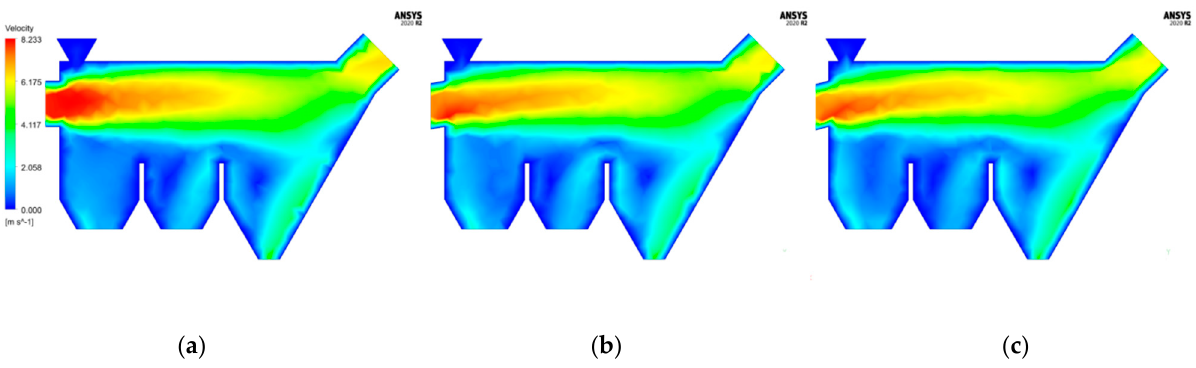
Figure 11. Streamline diagram of different types of airflow inclined angles: ( a ) 0°; ( b ) 7.5°; ( c ) 15°.